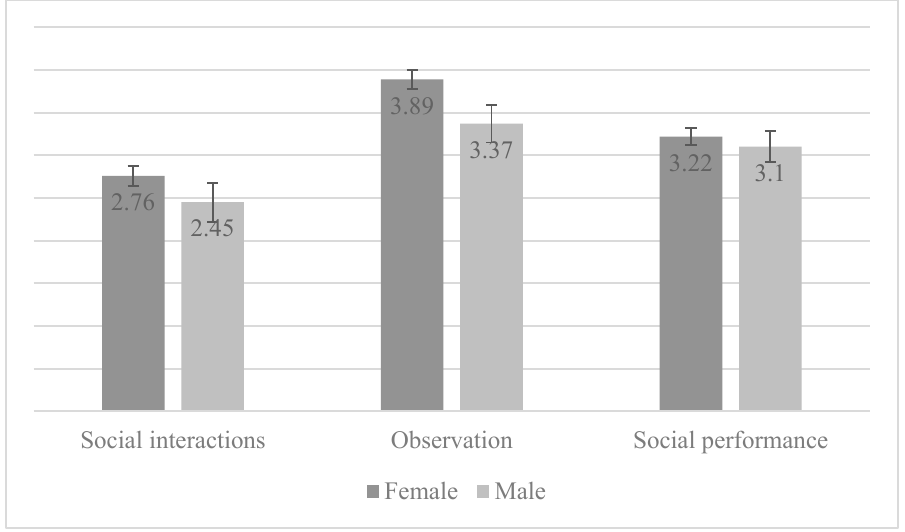
Figure 2. Core social fears by gender.